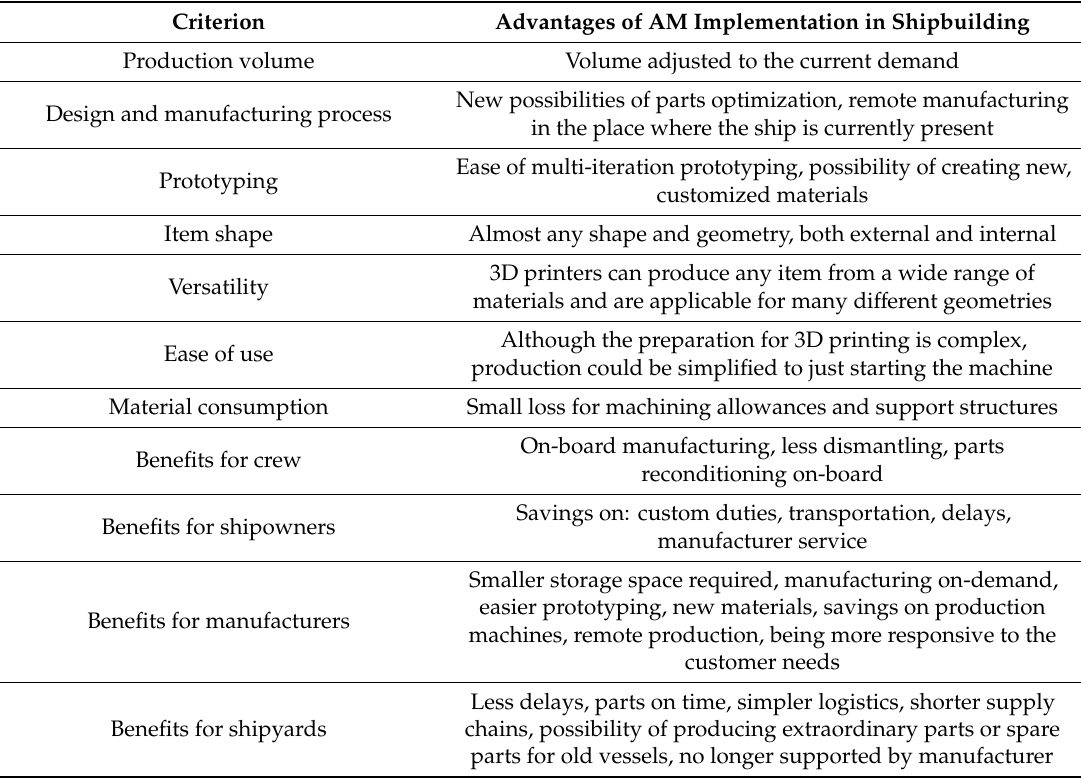
Table 5. Advantages of AM implementation in